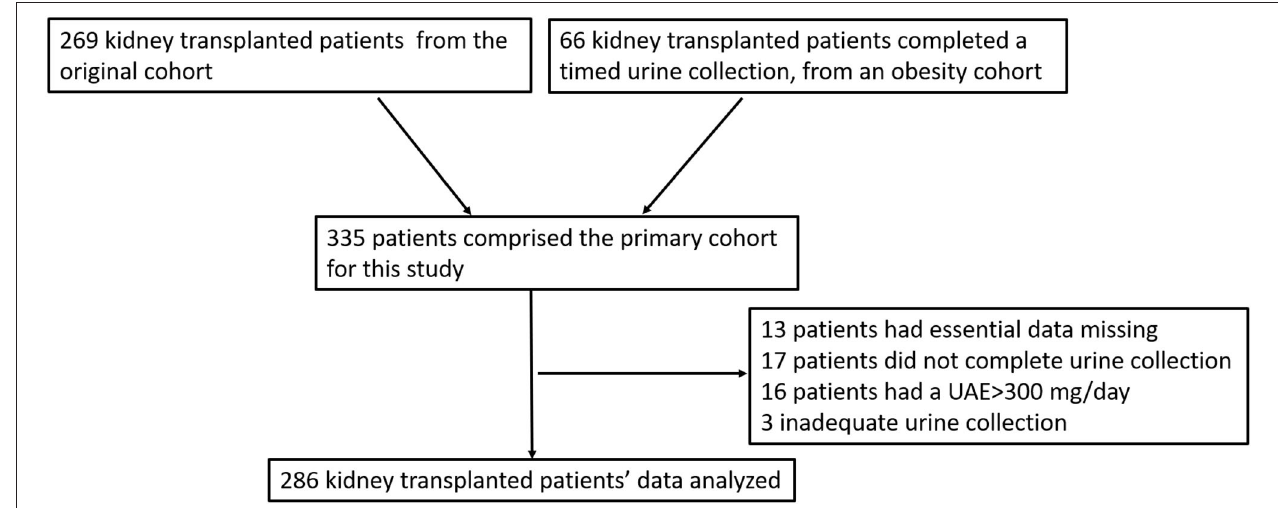
FIGURE 1 | Consort diagram describing addition and reduction of patient to create the analyzed